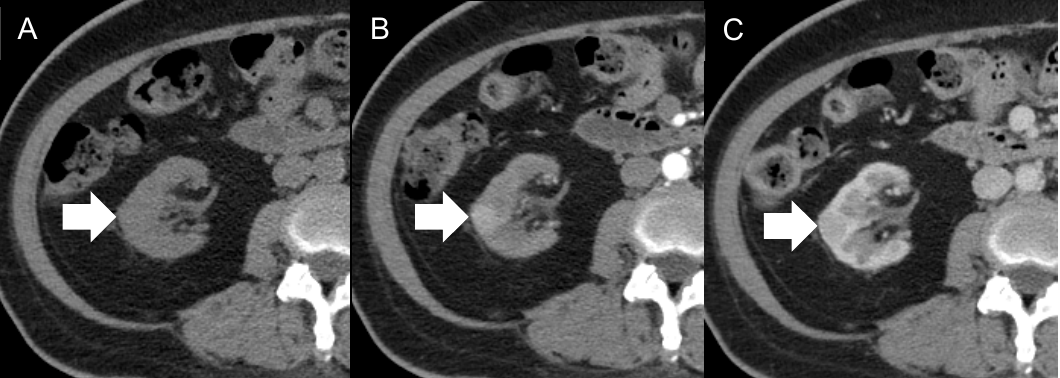
Figure 3. Axial computed tomography (CT) with dynamic contrast enhancement of the case. The lesion (arrow) is relatively isodense on pre-contrast CT imaging ( A ), relatively early enhancement on arterial phase ( B ), and equivocal washout enhancement pattern with similar Hounsfield units on venous phase ( C ) as those on arterial phase. Neither abnormal enlargement of regional lymph nodes nor invasion of the adjacent structures is found.